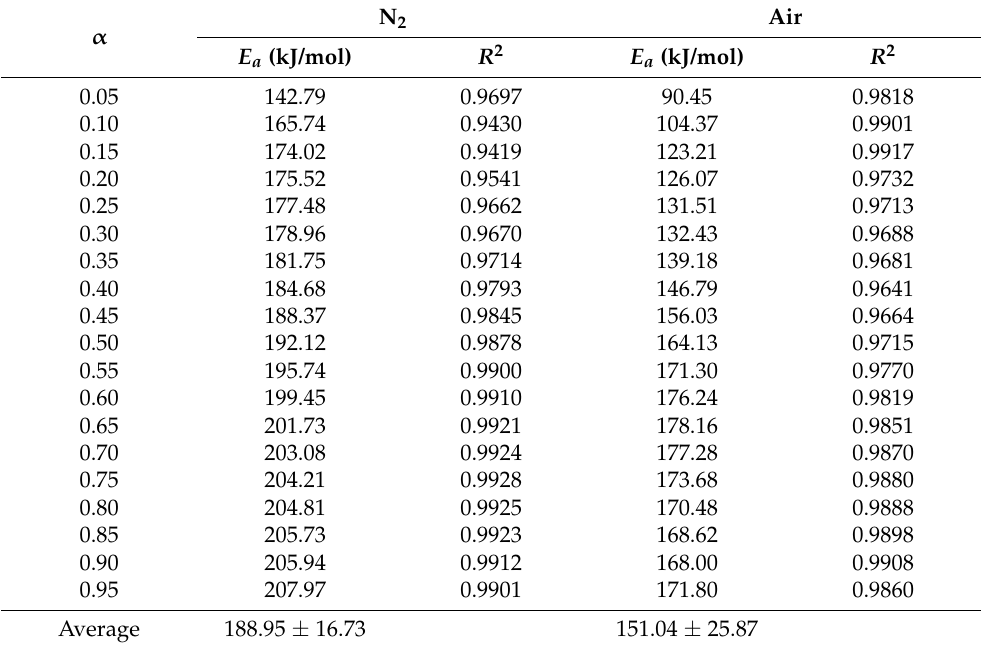
Figure 5. Linear SK plots of ln ( β / T 1.92 ) vs. 1000/ T obtained for tennis nylon waste in inert N 2 ( a ) and air ( b ). Table 2. Activation energies calculated using the SK method for thermal degradation of nylon-6 tennis string wastes.